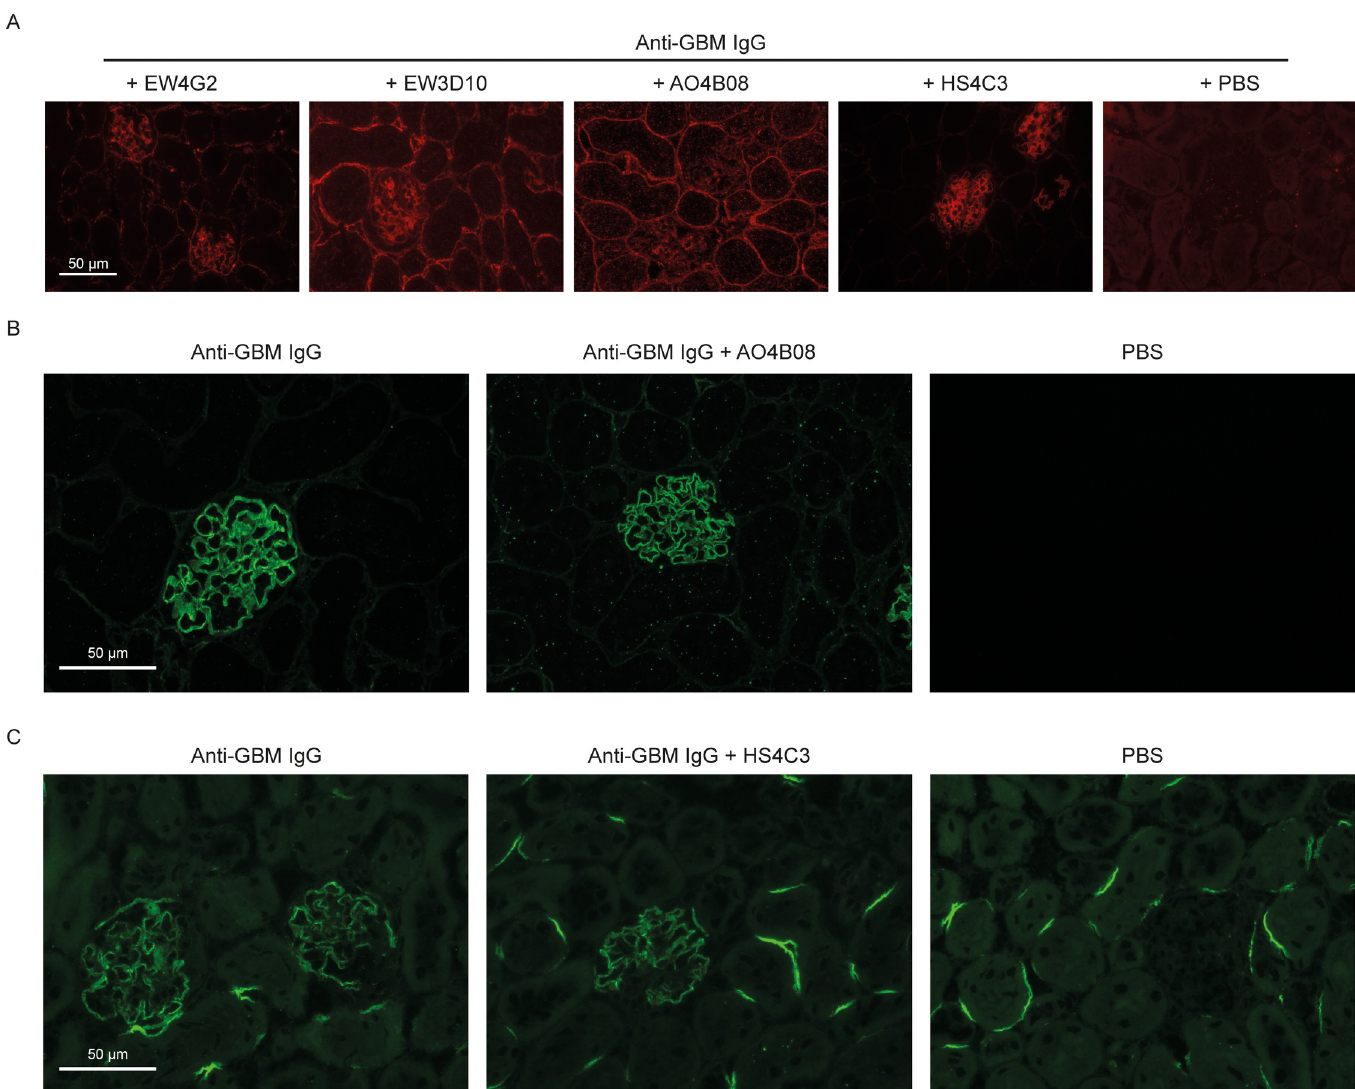
Fig 1. Detection of injected anti-HS antibodies, rabbit IgG and complement C3c in mouse glomeruli after anti-GBM-induced glomerulonephritis. Representative immunofluorescence stainings for (A) anti-HS antibodies with anti-VSV in glomeruli of mice co-injected with anti-GBM IgG serum and anti-HS antibodies, 2 hours after injection (40x magnification), (B) Staining for rabbit IgG in glomeruli of mice co-injected with anti-GBM IgG and anti-HS antibody AO4B08, 2 hours after injection (40x magnification), and (C) Staining for complement C3c in glomeruli of mice co-injected with anti-GBM IgG and anti-HS antibody HS4C3, 2 hours after injection (40x